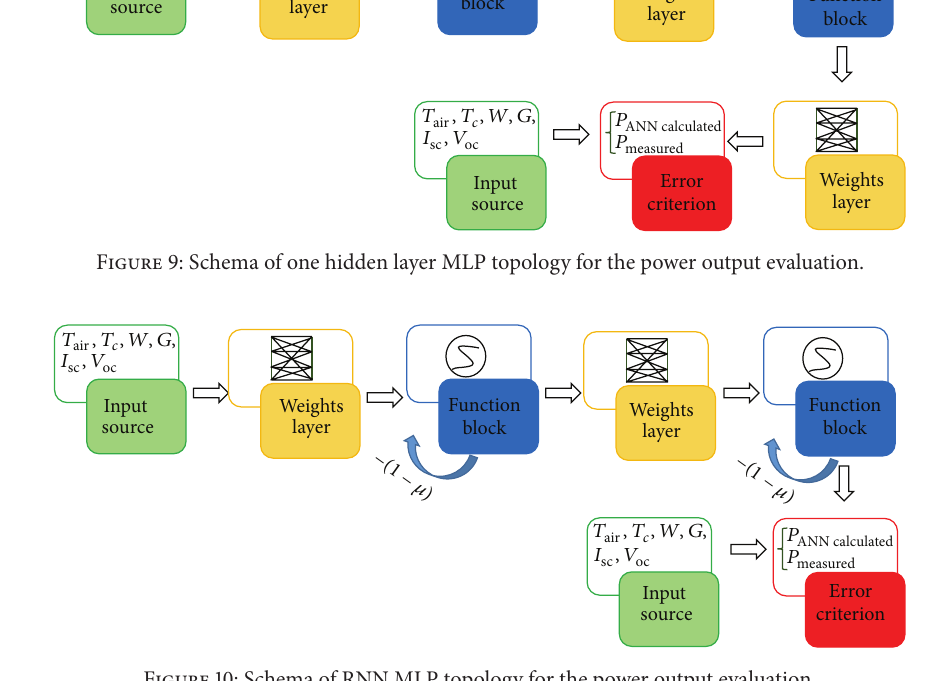
Figure 9 schematizes the tested one hidden layer MLP topology to evaluate power output of a PV